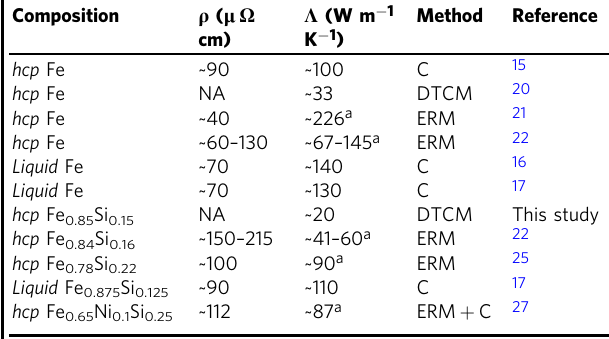
Fe – Si alloys at outer core conditions.